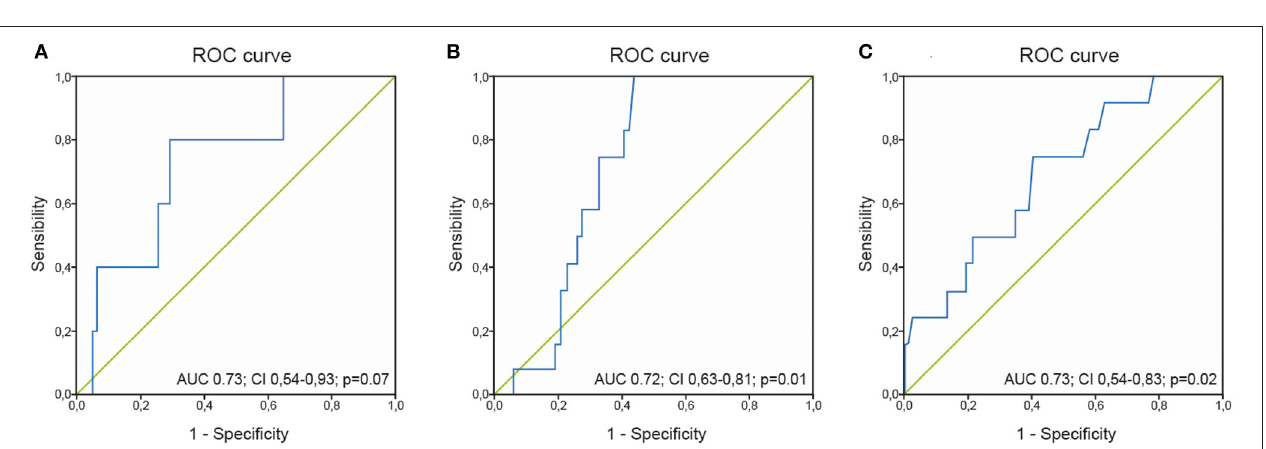
FIGURE 1 | Clearance of lactate levels in the first 48 post-operative hours.